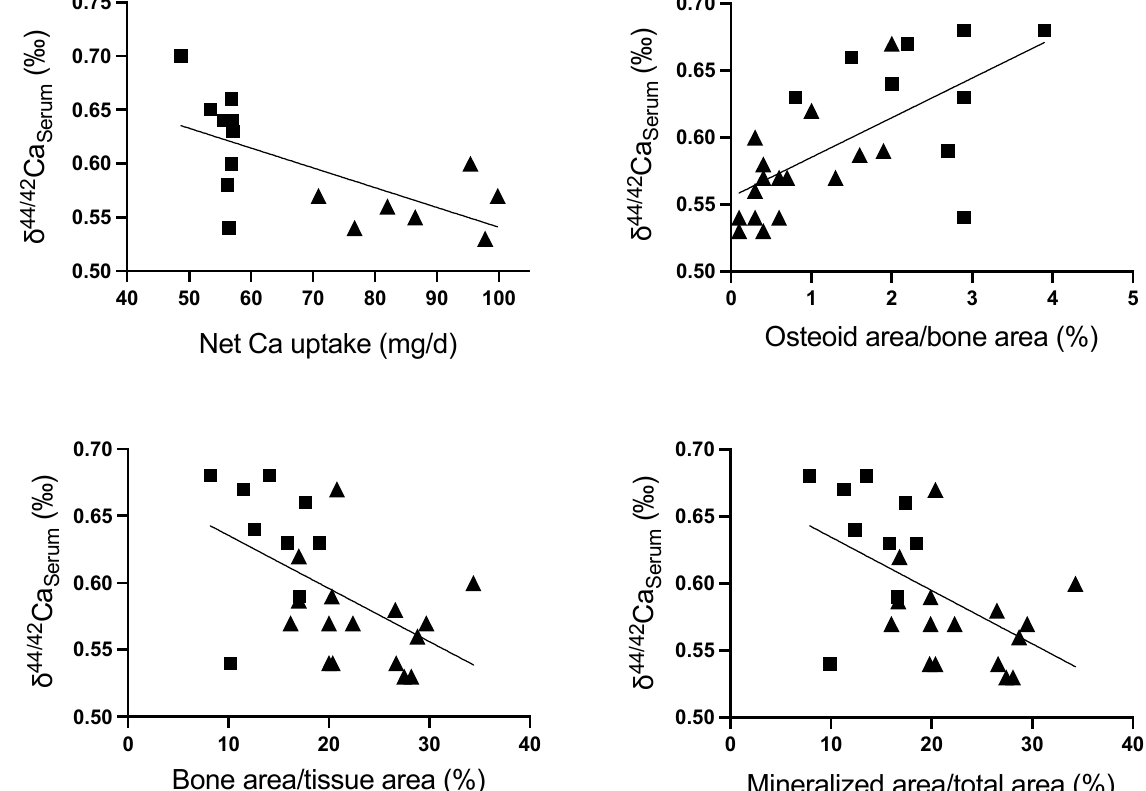
Figure 4. δ 44/42 Ca Serum, net intestinal Ca uptake and bone histology findings. δ 44/42 Ca Serum in rats on standard-diet (triangles; baseline values, group 2 weeks three to six) and low-Ca-diet (squares; group 3, weeks three to six) are shown relative to net intestinal Ca uptake and key bone histology parameters. Mean weekly δ 44/42 Ca Serum during weeks three to six inversely correlated with the net intestinal Ca uptake during this period (pearsons correlation, r = − 0.62, p = 0.007; n = 16). At sacrifice, δ 44/42 Ca Serum correlated with osteoid area/bone area (pearsons correlation, r = 0.64, p = 0.0005, n = 25) and negatively with bone area/tissue area (pearsons correlation, r = − 0.53; p = 0.007, n = 25) and mineralized area/total area (pearsons correlation, r = − 0.53, p = 0.006; n = 25).